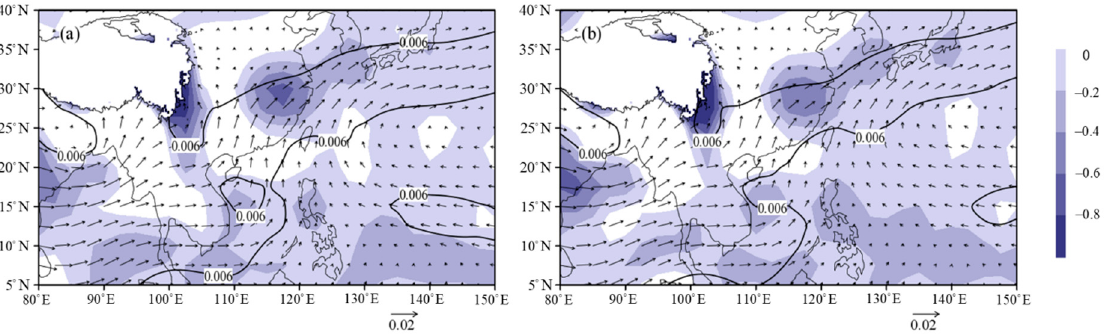
Figure 7. Water vapor flux field at 850 hPa (vector, unit: s − 1 , the solid line denotes 0.006 s − 1 line) and its divergence field (shaded, unit: 10 − 8 g /(s ∙ cm 2 ∙ hPa)) of Meiyu in the 1990s ( a ) and 2010s ( b ). Table 3. Intensity index of water vapor channel in Meiyu period ( unit: kg ∙ m − 1 ∙ s − 1 ). Water Vapor Channels